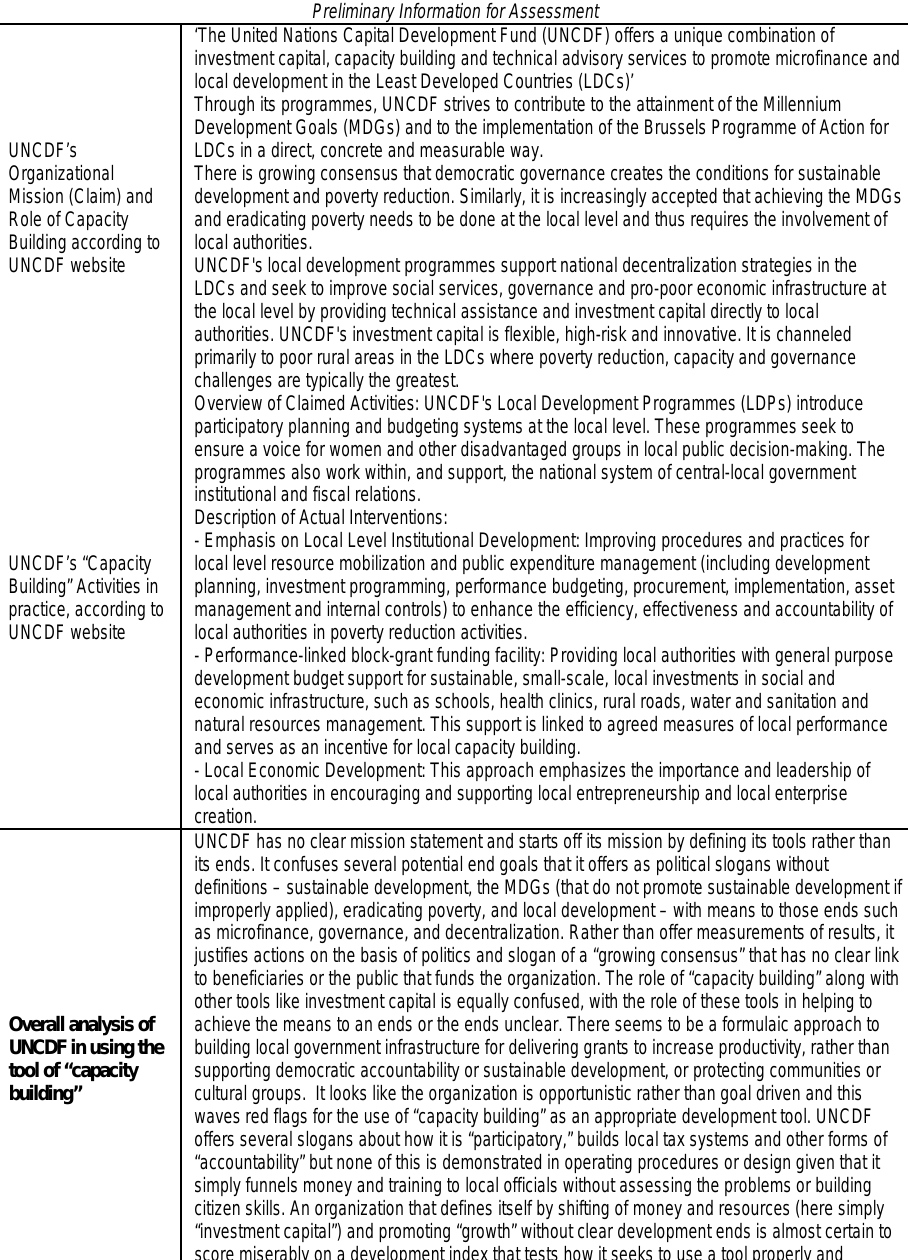
Section V: An example of applying the indicator: The United Nations Capital Development Fund Scoring of United Nations Capital Development Fund (UNCDF) on the